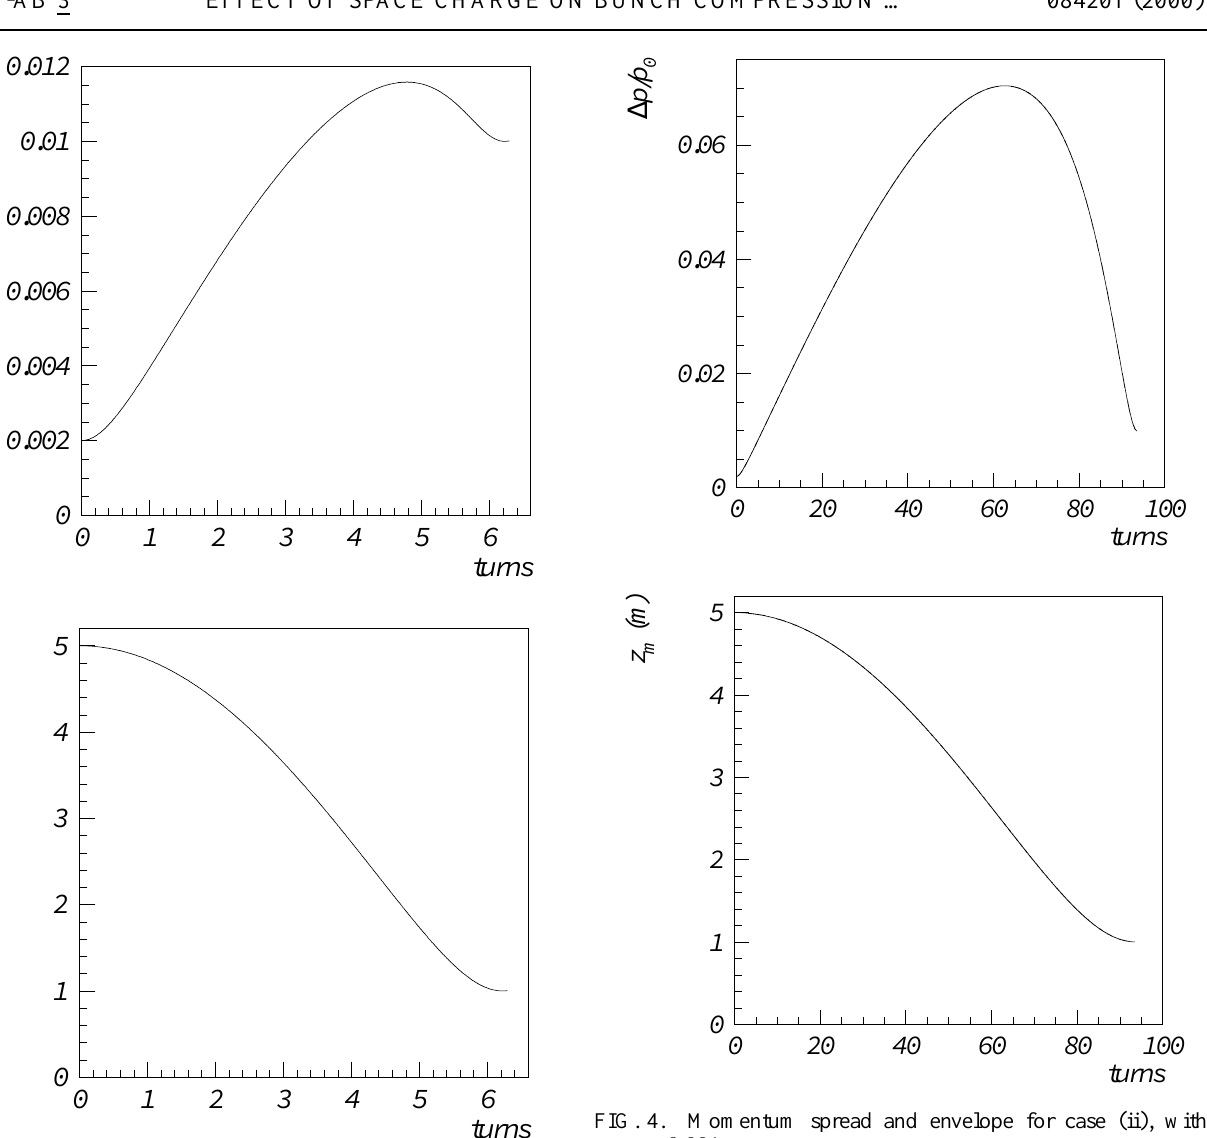
FIG. 3. Momentum spread and envelope for case (i), with h (cid:1) 2 0.1 .